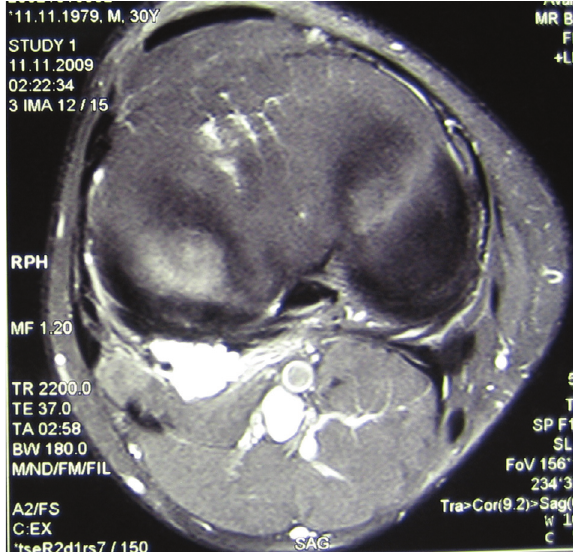
Figure 4. Perimeniscal cyst is seen on the axial MR imaging of the posterior horn of the lateral meniscus of right